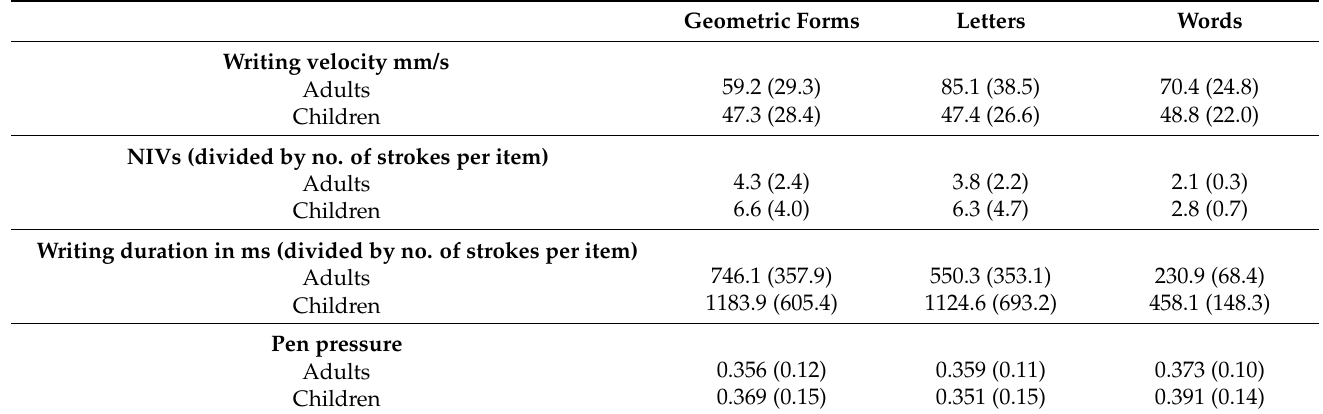
Table 1. Means and standard deviations in parentheses for the handwriting process measures for adults ( n = 18) and children ( n =